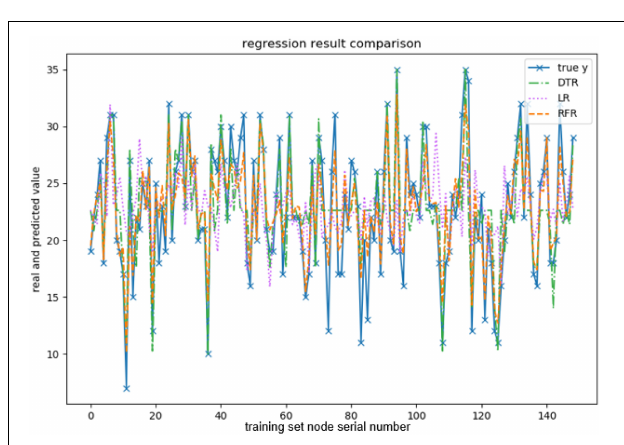
FIGURE 7 | Comparison of neuroticism-predicted values.